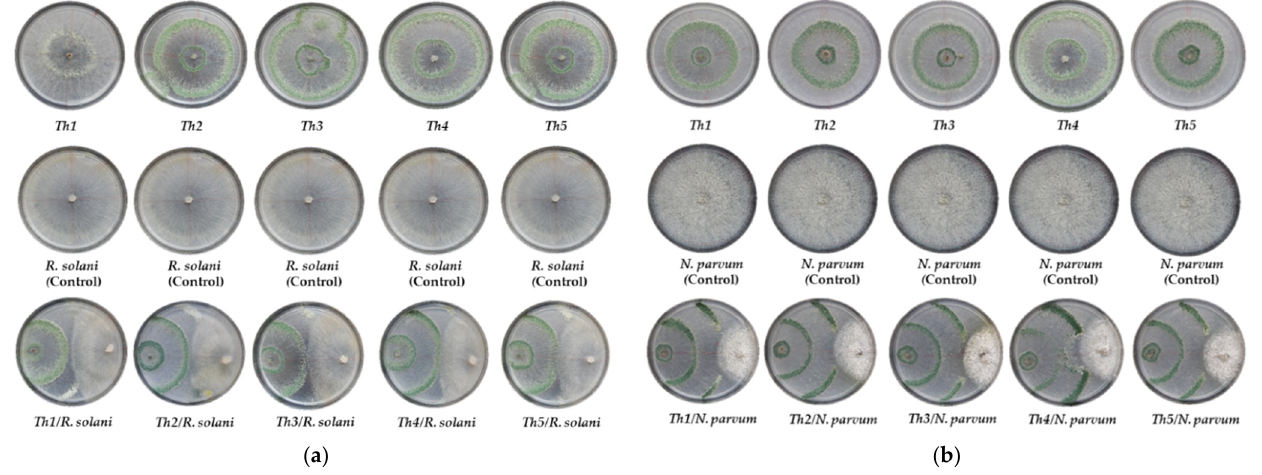
Figure 4. Dual plate confrontations of Trichoderma harzianum strains against the selected pathogens. ( a ) Rhizoctonia solani . Top row: control plates of the different strains of T. harzianum ; middle row; control plates of R. solani ; bottom row: dual confrontations with each of the protective strains; ( b ) Neofusicoccum parvum . Top row: control plates of the different strains of T. harzianum ; middle row; control plates of N. parvum ; bottom row: dual confrontations with each of the isolates of T. harzianum .